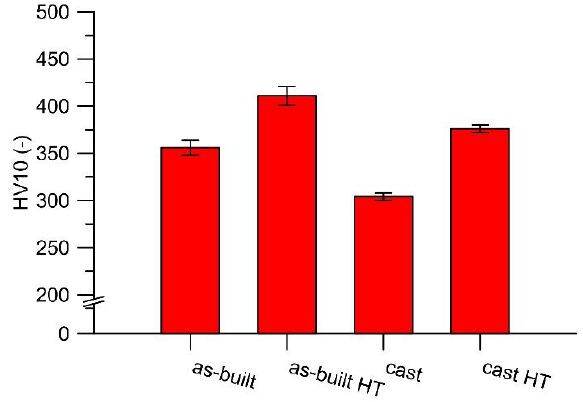
Figure 14. Hardness changes after heat